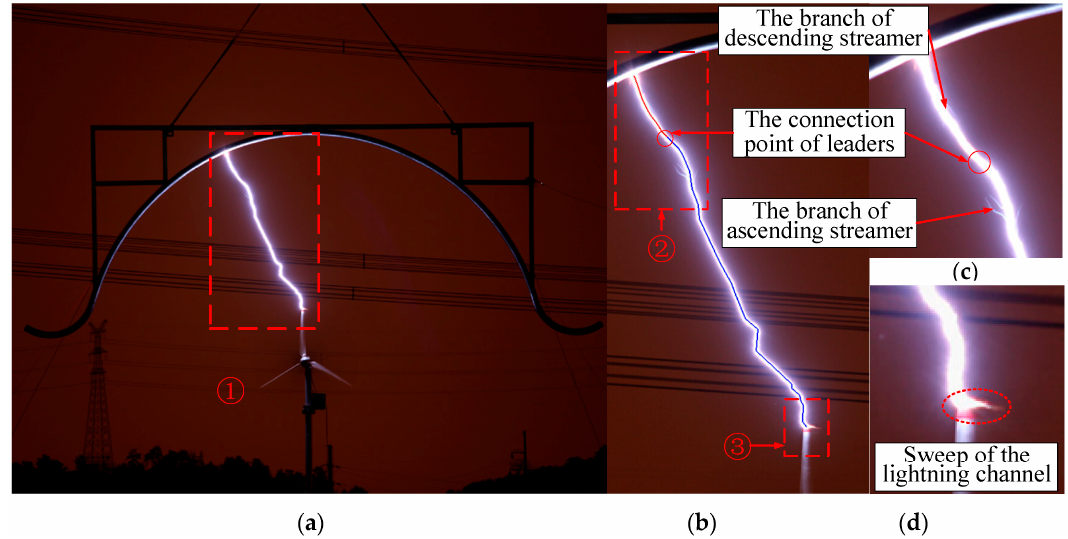
Figure 6. The typical discharge process of the rotating wind turbine with the 4 m air gap. ( a ) overview of the breakdown path; ( b ) ascending leader and descending leader length measurement (enlargement/magnification of ① ); ( c ) ascending leader and descending leader connection (enlargement/magnification of ② ); ( d ) lightning discharge on the blade tip in the rotating process (enlargement/ magnification of ③ ).